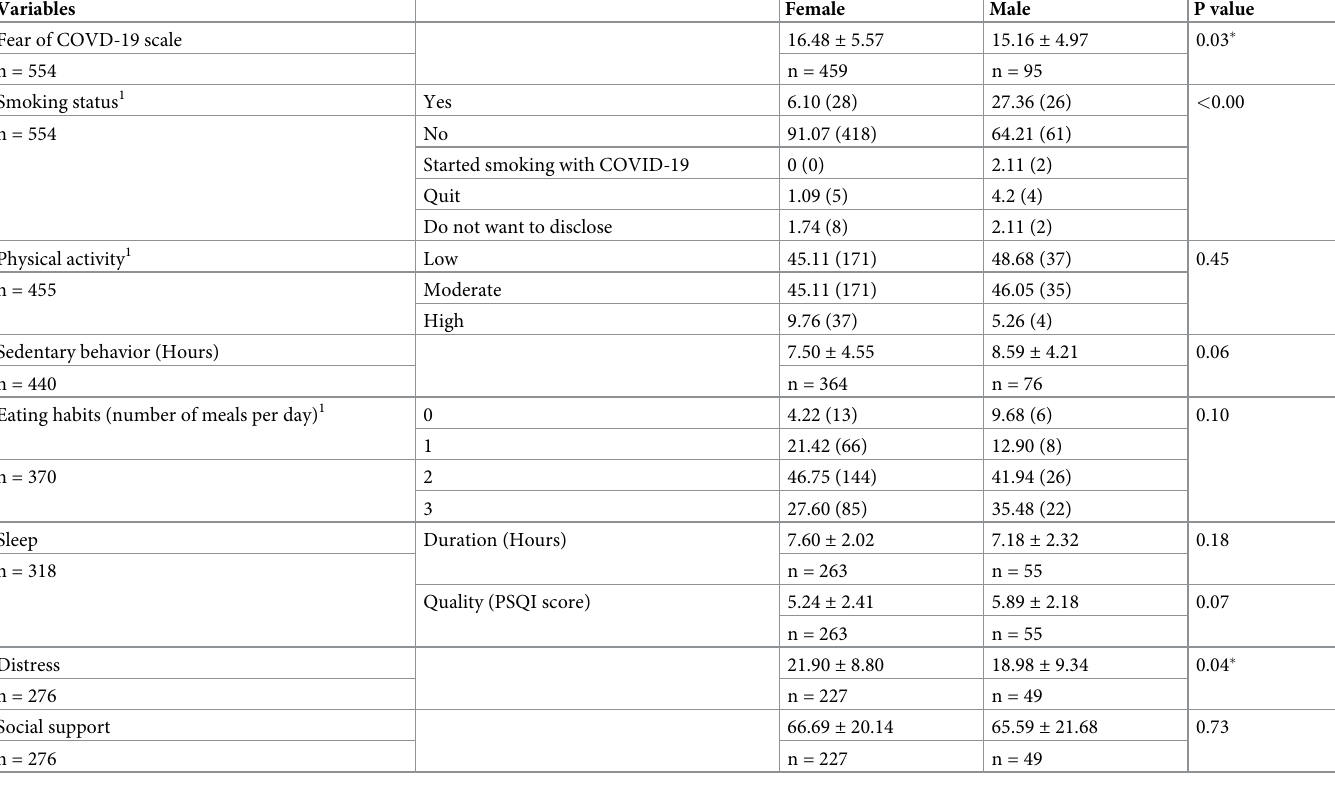
Table 3. Level of fear of COVID-19 and lifestyle behaviors divided by sex in the general public living in areas with stay home advisory implemented in Saudi Arabia.